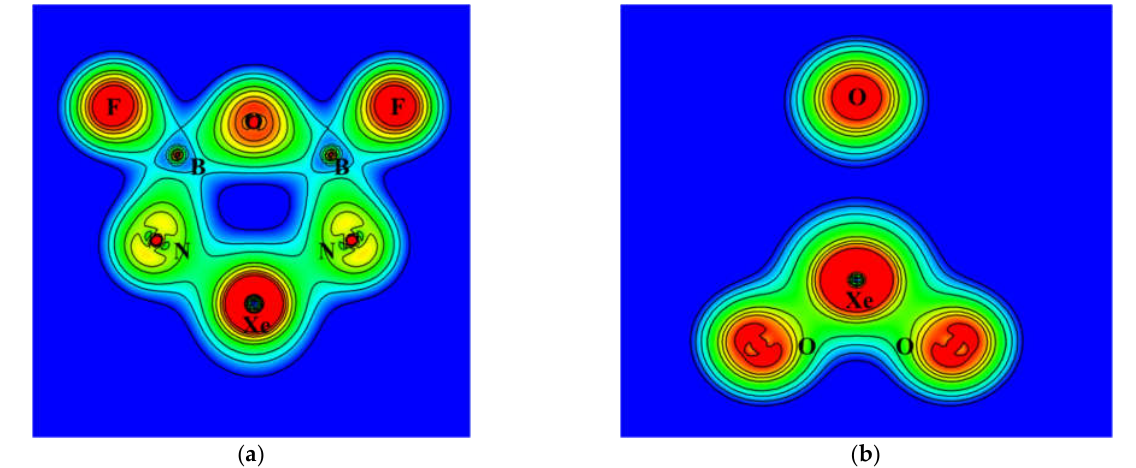
Figure 6. Contour plots of the calculated electron density of XeO 3 N 2 B 2 F 2 on ( a ) the ring plane ( b ) the XeO 3 plane.